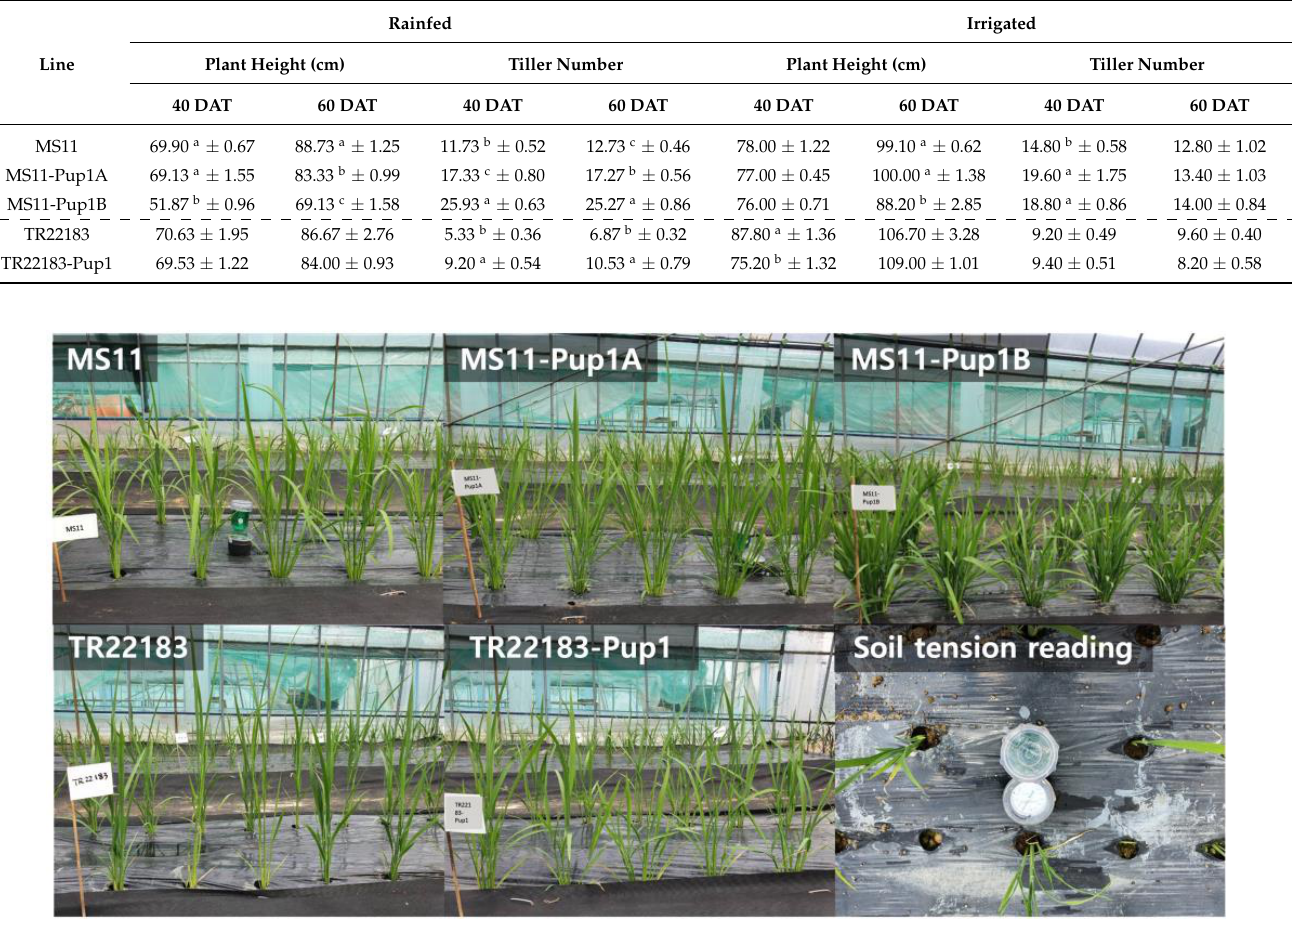
Figure 4. Early vigor detected in Temperate-Pup1 introgression lines under rainfed conditions (2021).